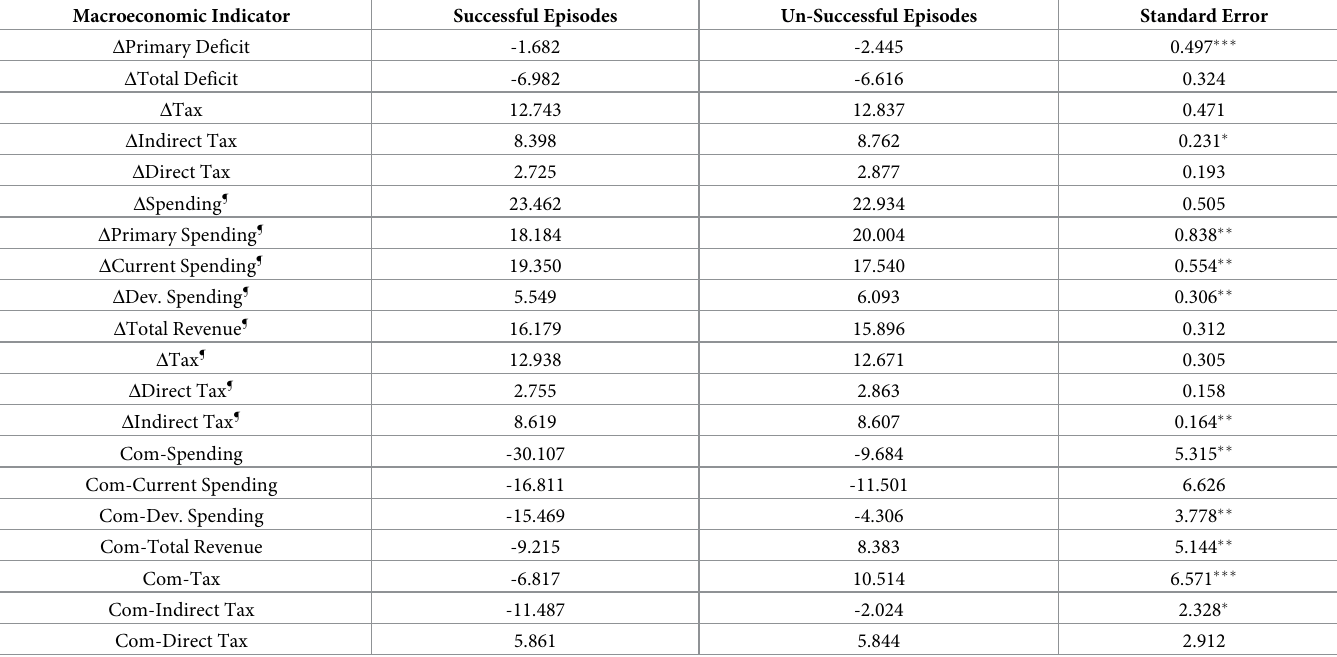
Table 4. Macroeconomic effects of composition of fiscal